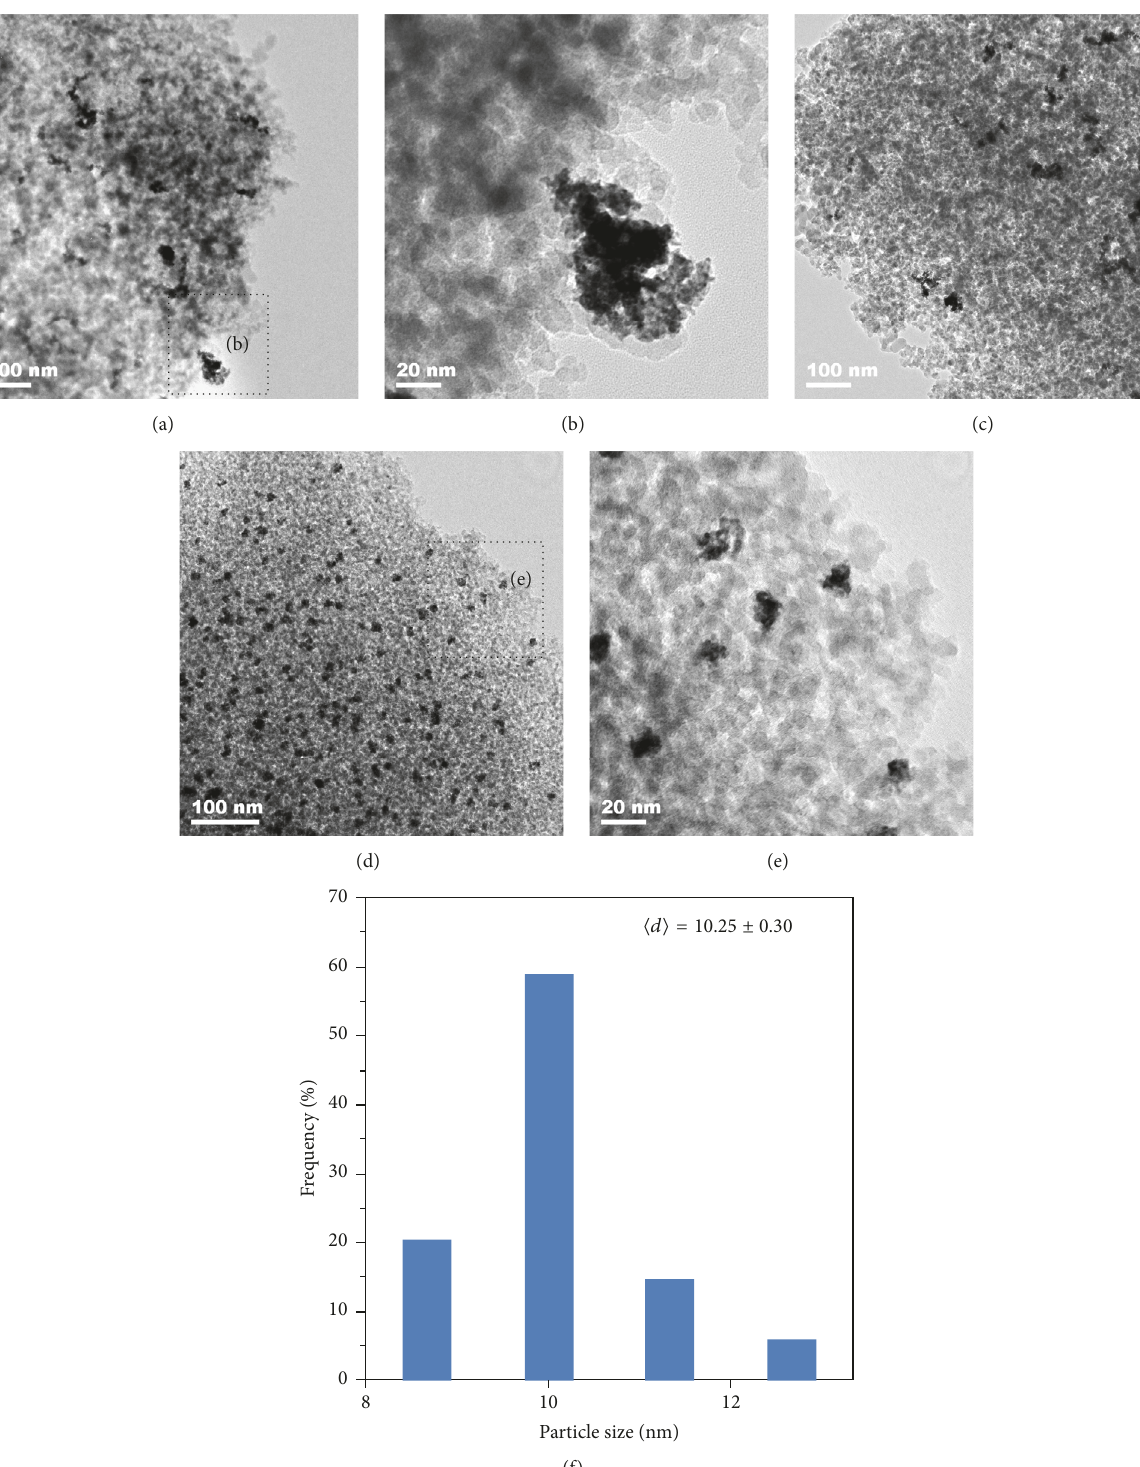
Figure 2: ((a), (b), and (c)) TEM images for the Pt/SiO 2 sample; ((d), (e)) TEM images and size distribution of particles for the Pt-Cu/SiO 2 sample. (f) is the size histogram of the particle distribution and the average size of the particles determined by statistical analysis of the TEM images; at least 50 individual crystallites were